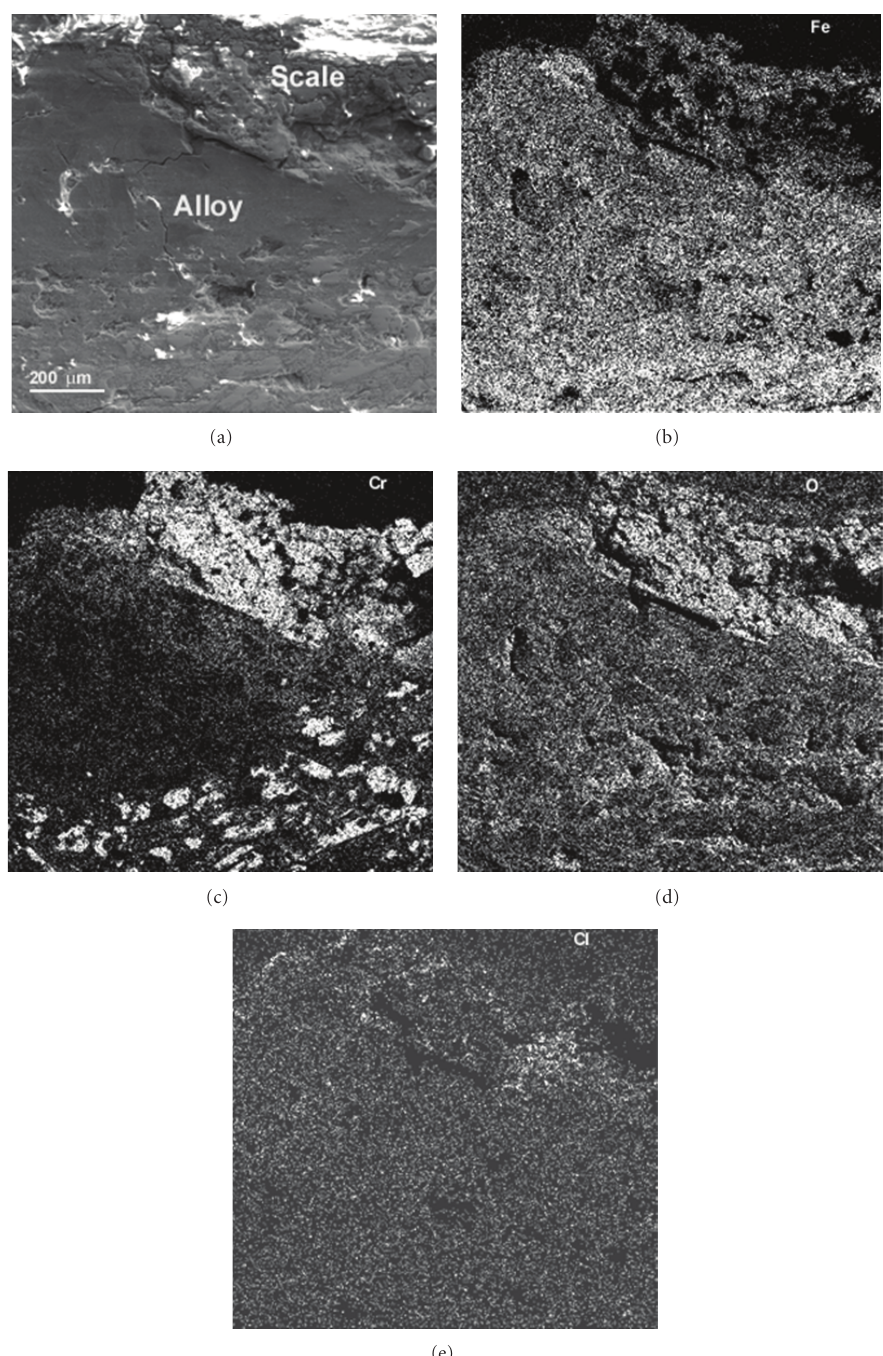
Figure 7: Micrograph of cast iron containing 5.31 C E -corroded NaCl-KCl at 670 ◦ C during 96 h together with X-ray mappings of Fe, Cr, O, and